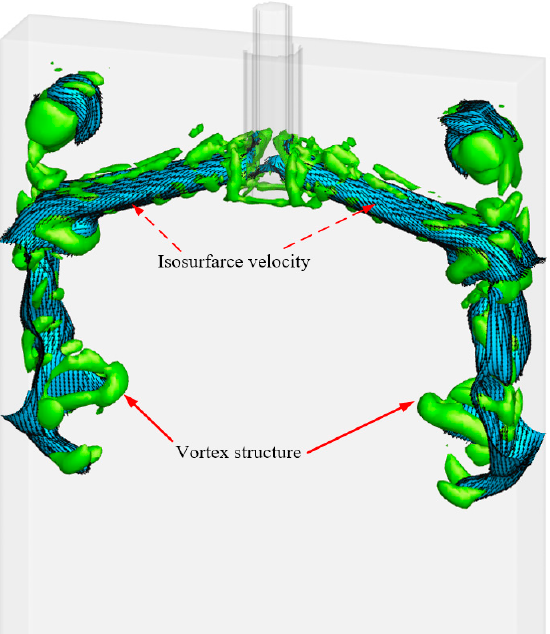
Figure 10. Typical flow of the upper and lower streams near the wall of the mold and corresponding vortex structures using a vorticity w of 10.